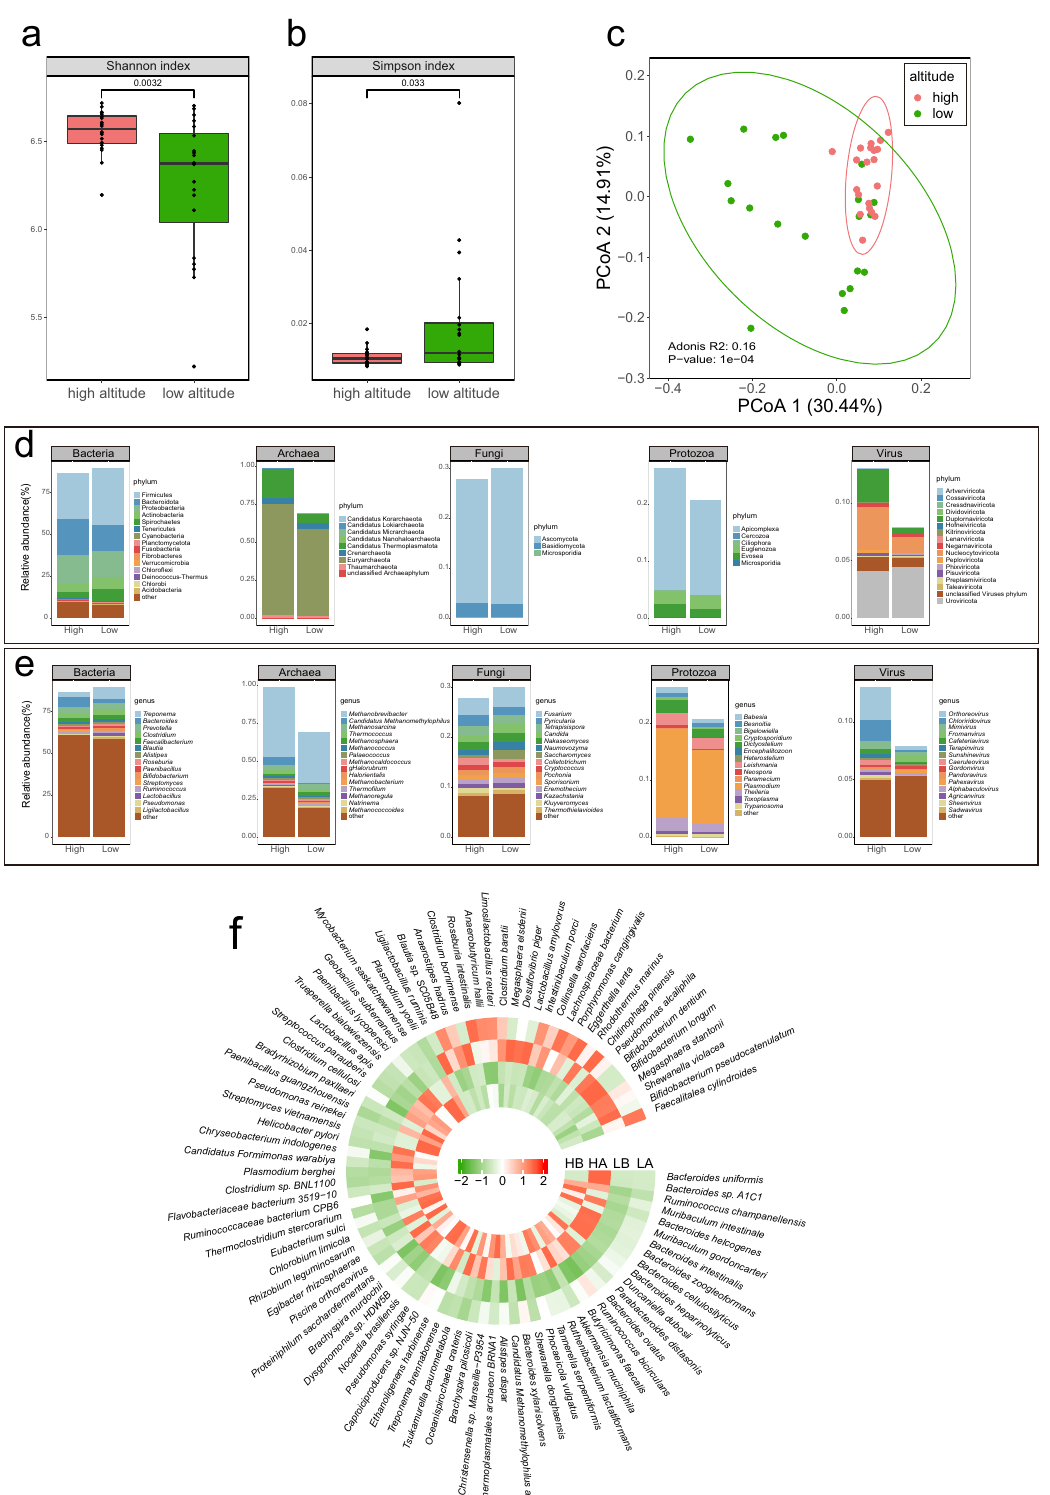
Fig. 1 Differences in gut microbiota taxonomic composition between high-altitude populations and low-altitude populations of the wild rhesus macaque. a , b Alpha diversity differences (Shannon index, Simpson index; Welch ’ s t -test), The boxes represent 25th – 75th percentiles, black lines indicate the median and whiskers extend to the maximum and minimum values within 1.5× the interquartile range, point represents the actual value of the sample. c Principal coordinate analysis (PCoA) of individuals in high and low altitude populations based on gut microbiota at the species level (Bray – Curtis distance; Adonis test, R 2 = 0.16, P < 0.001), The ellipse borders represent the 95% con fi dence interval. d Relative abundance of gut microbiota taxa at the phylum level. e Relative abundance of gut microbiota taxa at the genus level. f Species level differential relative abundance heatmaps of the gut microbiota between high-altitude and low-altitude populations in the RMs (LEfSe analysis, LDA > 2, P <